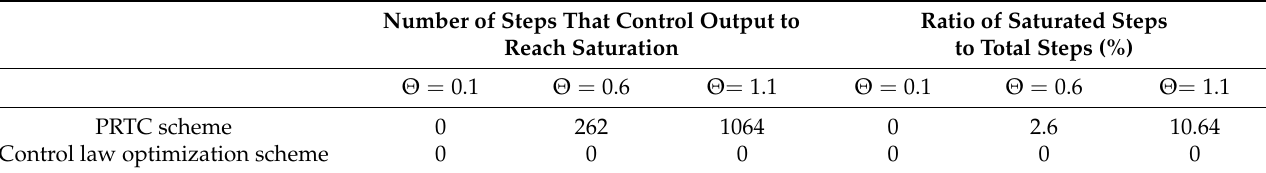
Table 4. Performance of PRTC scheme and control law optimization scheme in control output.